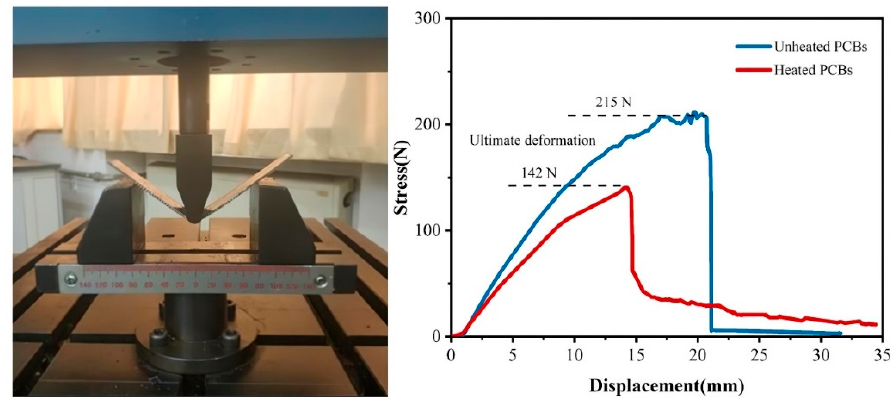
Figure 4. Measurement results of mechanical characteristics.